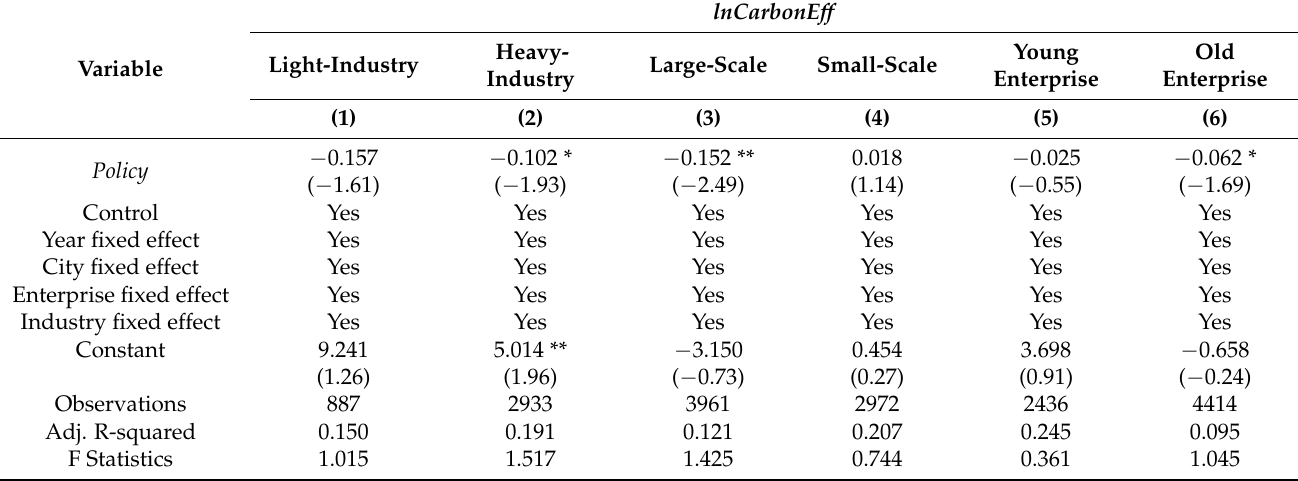
Table 5. Regression results of the heterogeneity